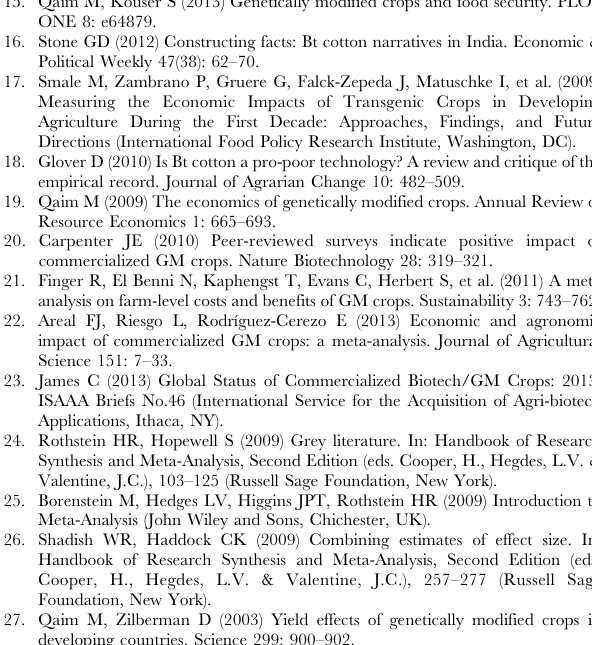
Figure S1 Histograms of effect sizes for the five outcome variables. Figure S2 Impacts of GM crop adoption including only studies published in journals. Figure S3 Funnel plots for the five outcome variables. Table S1 List of publications included in the meta- analysis.